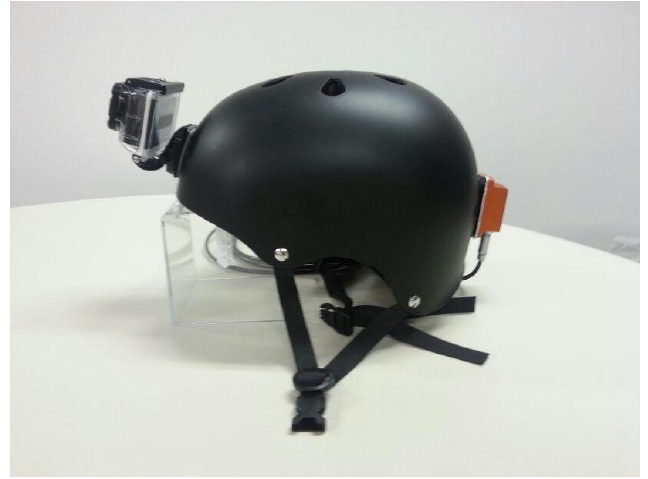
Figure 9. View of the helmet with the camera and AHRS unit placement